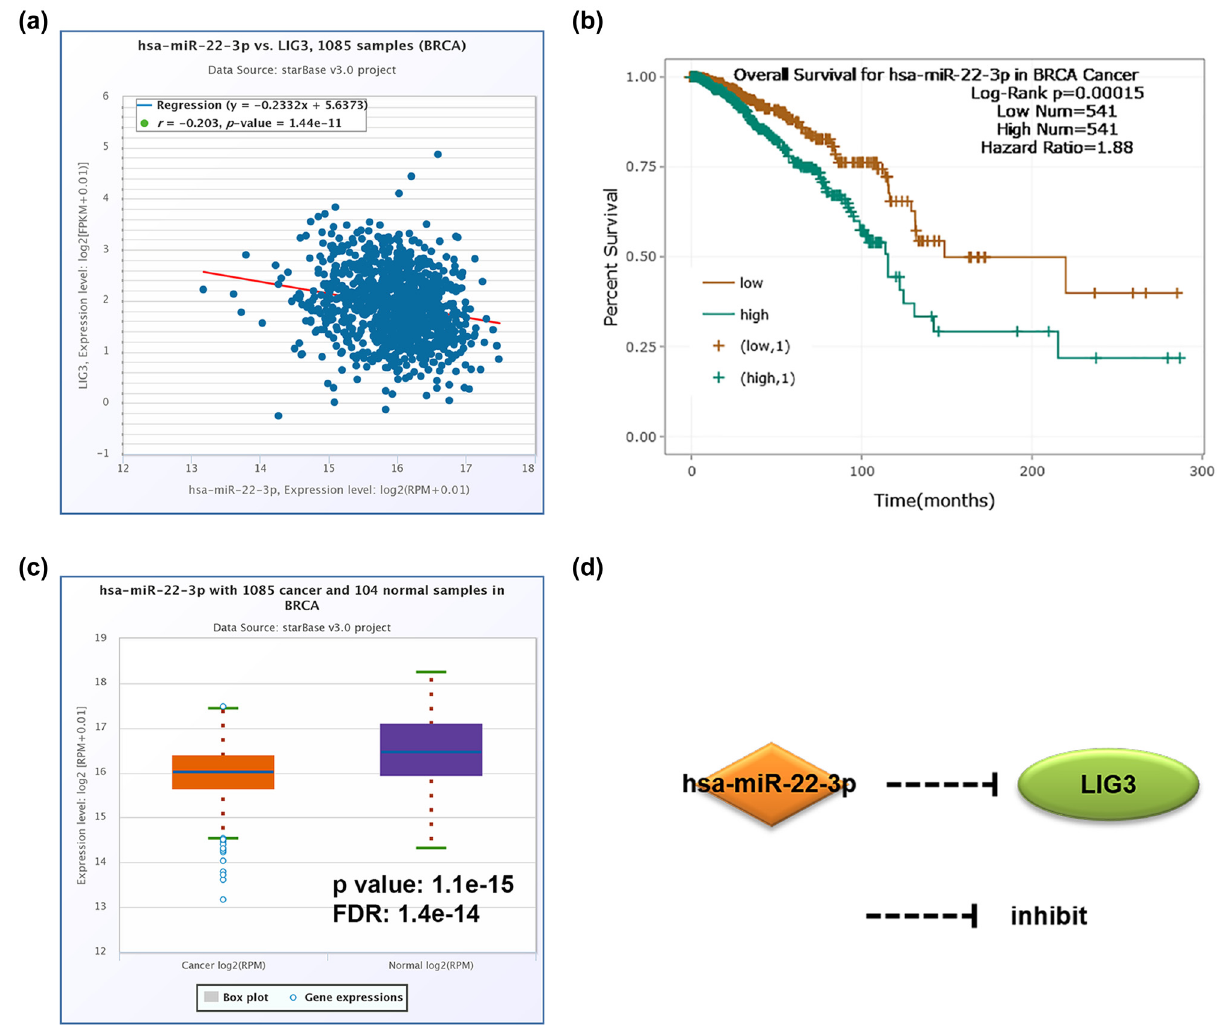
Figure 6: Regulatory miRNA - regulated LIG3 was identi fi ed and the expression and prognostic value of the miRNA in BC patients was analyzed. ( a ) has - miR - 22 - 3p negatively regulated LIG3 expression inBC. ( b ) The decreased expression of has - miR - 22 - 3p predicted good prognosis for BC patients. ( c ) The expression of has - miR - 22 - 3p was decreased in BC compared to normal samples. ( d ) The has - miR - 22 - 3p - LIG3 regulatory